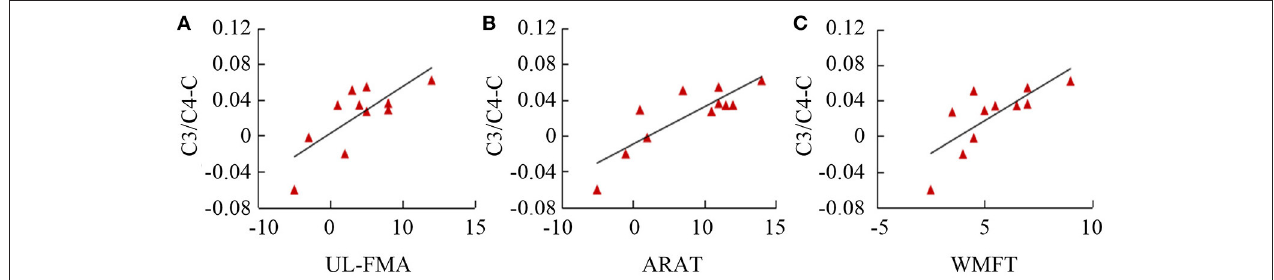
FIGURE 8 | Correlation of fApEn with clinical scales ( A , UL-FMA; B , ARAT; and C , WMFT) in stroke patients.